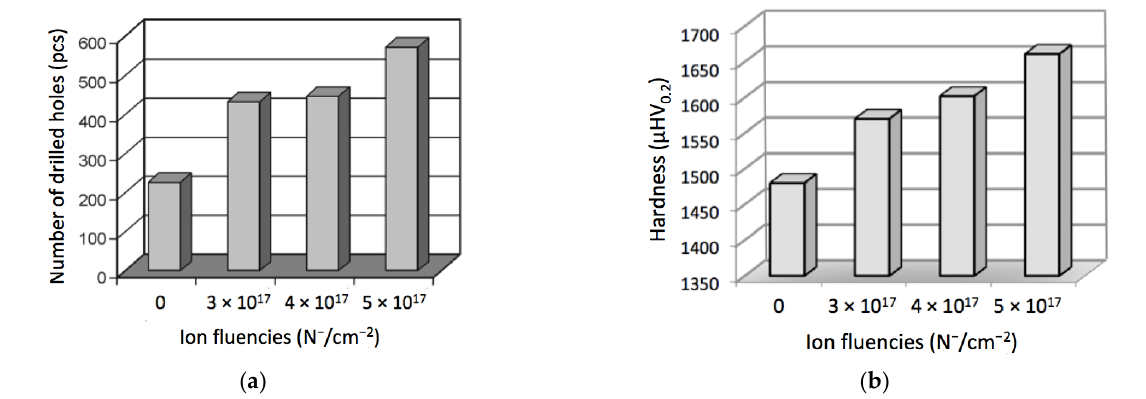
Figure 8. Effect of ion implantation on the durability and hardness of the WC-Co drills: ( a ) number of the holes drilled before the tool was worn out; ( b ) microhardness dependent on the ion fluency.